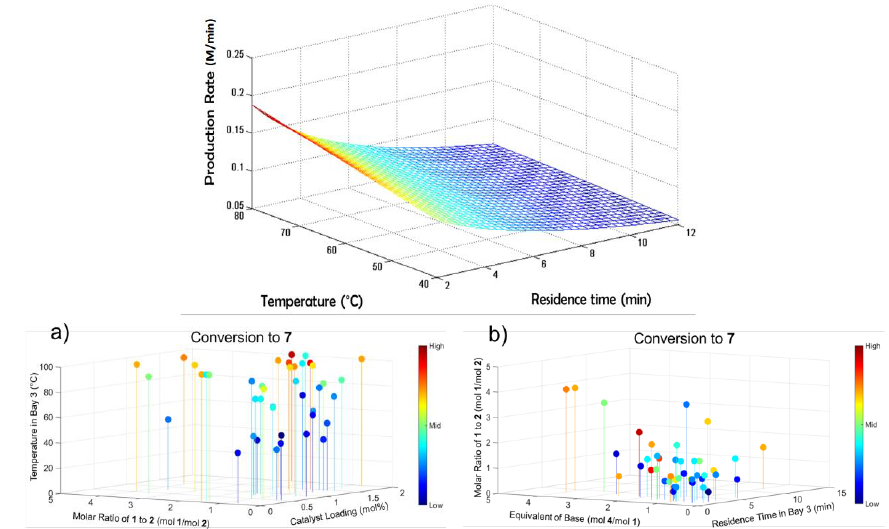
Figure 1. Reaction design space mapping in a reconfigurable continuous synthesis system: ( a ) Attained conversion vs. reagent molar ratios, catalyst loading and operating temperature, ( b ) Attained conversion vs. base equivalents, residence time and reagent molar ratios. Reproduced with permission from Bédard et al., Science; published by American Association for the Advancement of Science, 2018 [51].